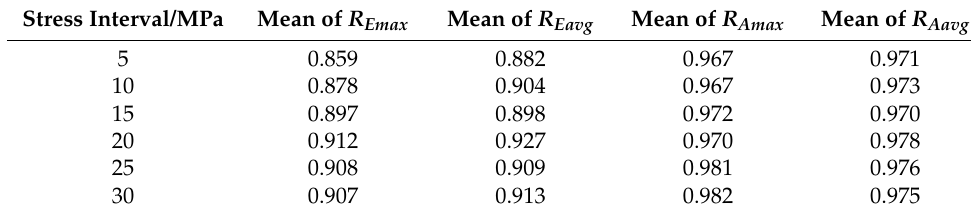
Figure 9. b value and its fitting goodness at different stress intervals for specimen G-10-10. The range of b Amax values is between 1.01 to 1.99. Table 4. The mean of R 2 at different AE stress proportion intervals for specimen G-10-10. Stress